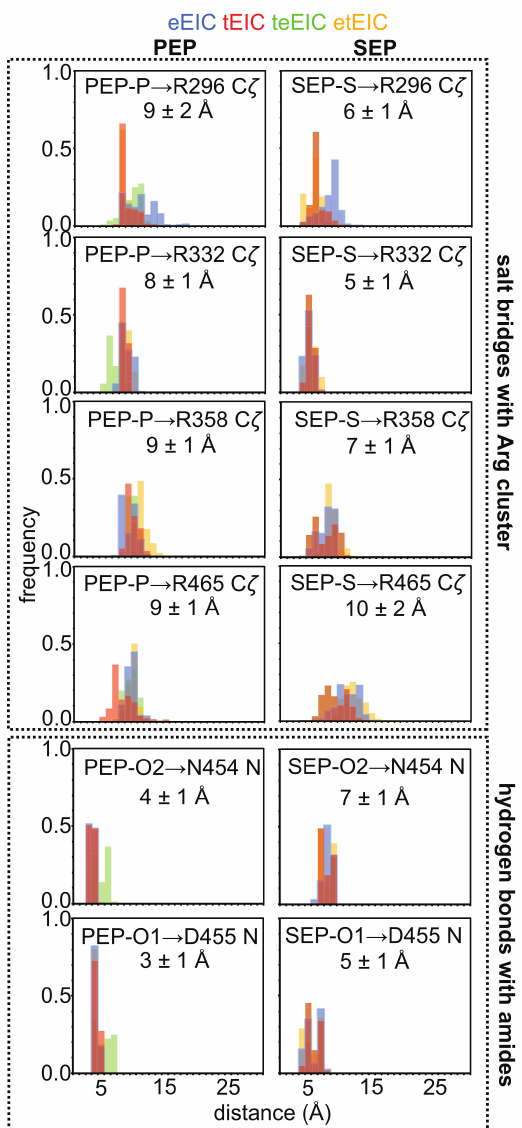
Figure 6. Histograms showing the distribution of interatomic distances for selected EIC–PEP (left column) and EIC–SEP (right column) contacts during the 0.5 us MD simulations acquired on the structure of the complexes formed by the ligands with eEIC (blue), tEIC (red), teEIC (green), and etEIC (orange). The P-C ζ and S-C ζ distances were analyzed to investigate the evolution of the salt bridges formed by Arg side chains with PEP and SEP, respectively. The N-O2 and N-O1 distances were analyzed to investigate the evolution of the hydrogen bonds formed by the ligand carboxyl group with the backbone amides of Asn 454 and Asp 455, respectively. The average distance obtained over the four simulations is reported per each